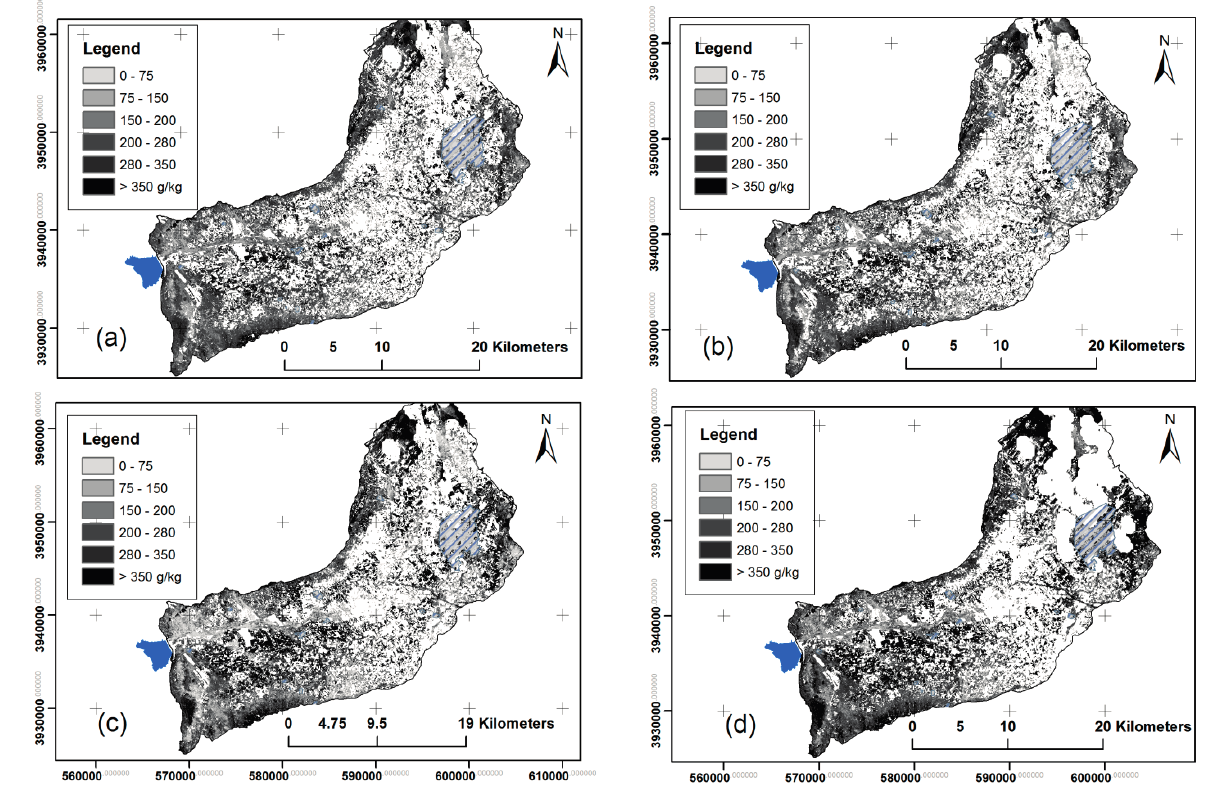
Figure 5. Clay content maps at 30 m spatial resolution obtained using relationships between observed clay content and mid-infrared index for each selected date: ( a ) 16 July 2009; ( b ) 1 August 2009; ( c ) 2 September 2009; and ( d ) 18 September